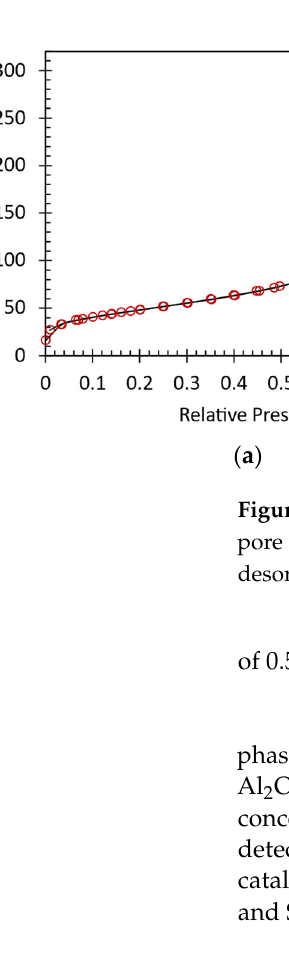
(A6) Table A4 reports the values of the kinetic parameters used in Equations (A3)–(A6). Table A4. List of parameters for the Pd-based membrane deactivation [23]. Kinetic Parameter